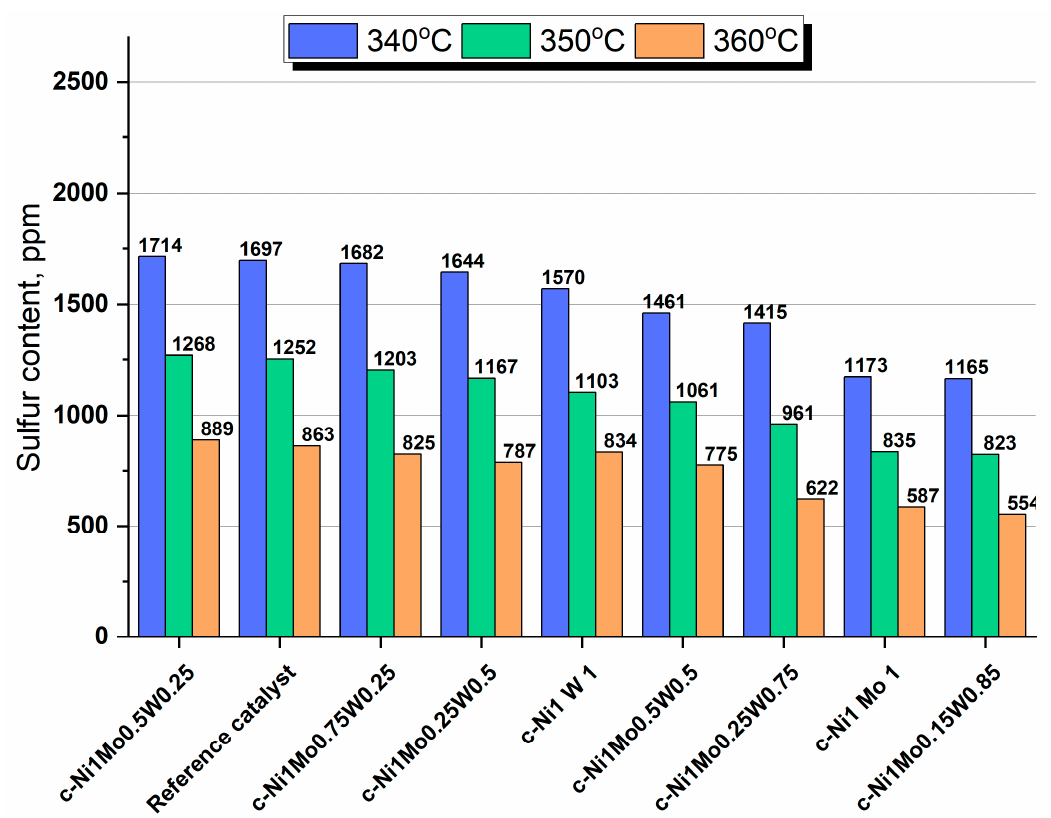
Figure 9. Residual sulfur content in hydrotreated products for bulk c—Ni 1 Mo x W y sulfide catalyst and the reference supported sample.